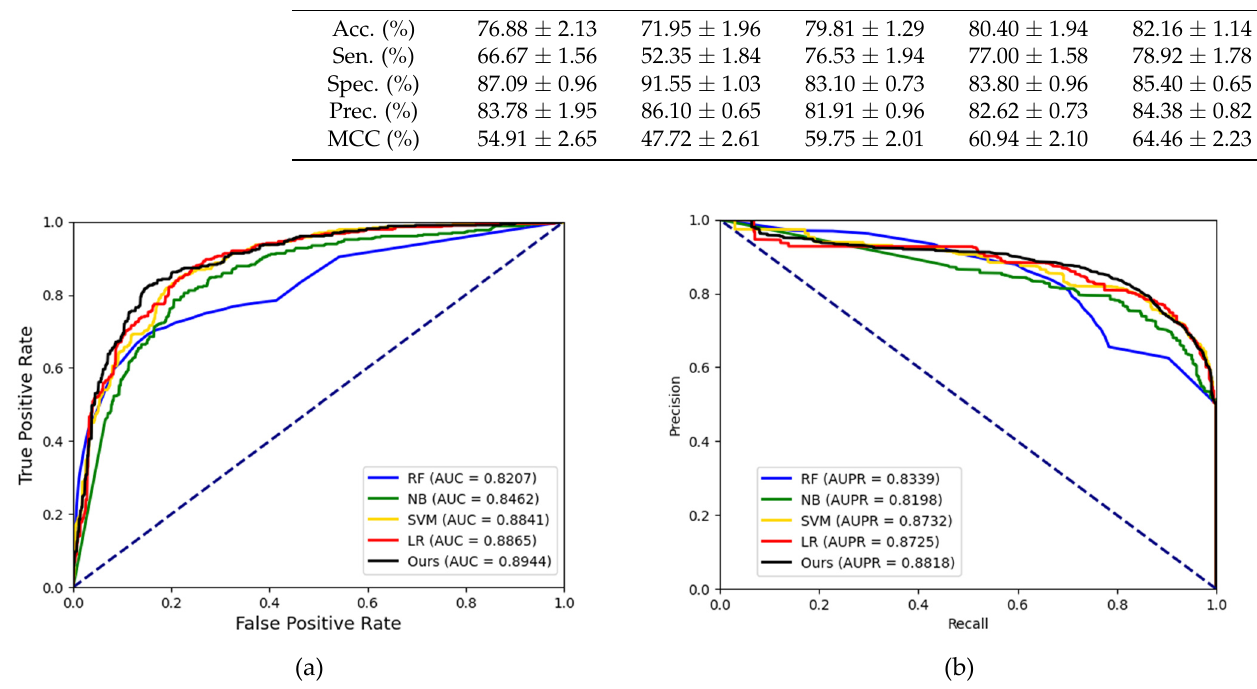
Figure 9. ( a ) The ROC curves of the result generated by different classifiers using the SM2miR dataset. ( b ) The PR curves of the result generated by different classifiers using the SM2miR dataset.